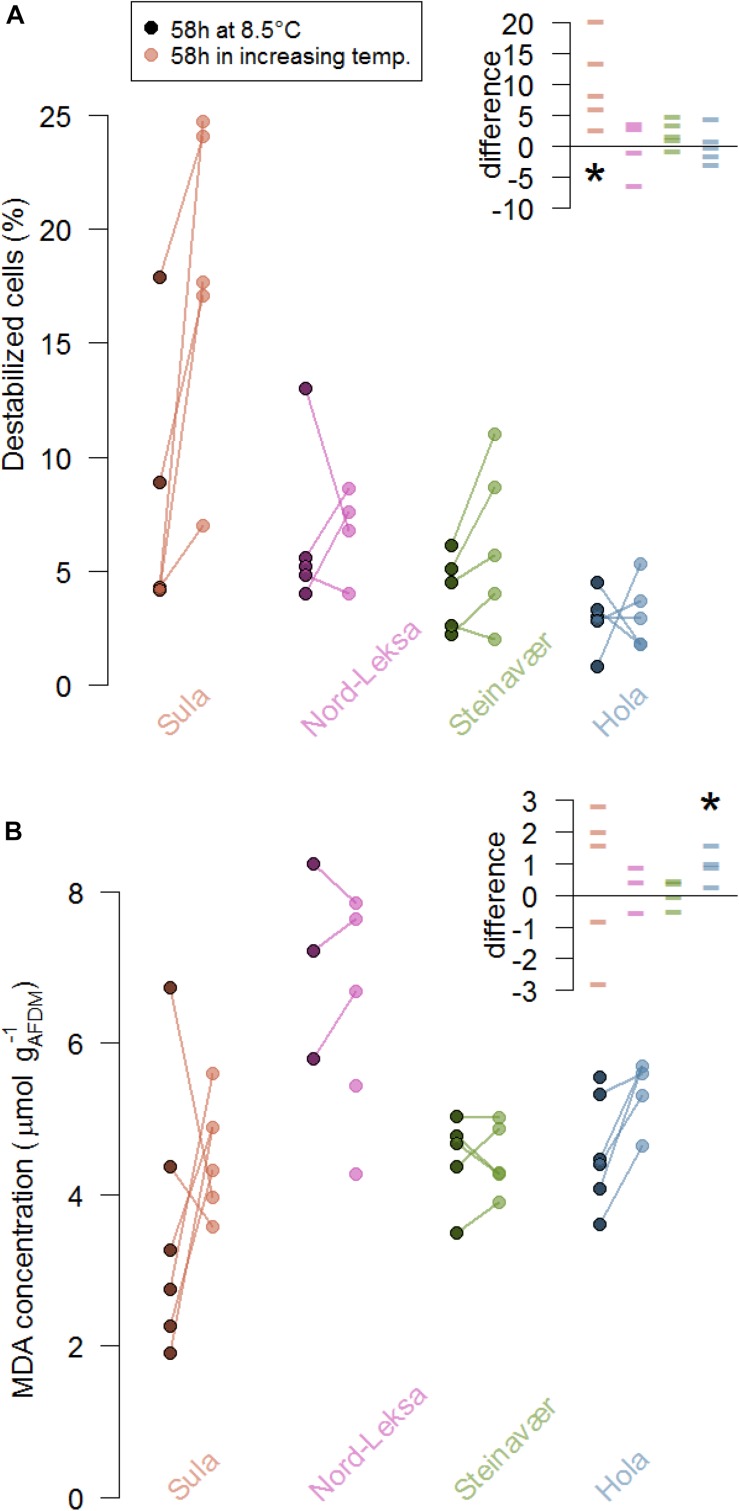
Stress markers of coral fragments from the four reefs (colors) as indicated by (A) lysosome destabilization of the corals’ cells (%) and (B) malondialdehyde concentration (MDA, μmol L−1 gAFDM–1) at the end of the experiment (58 h). At each reef, five colonies were fragmented and five fragments were exposed to increasing temperature (color dots) while five were exposed to ambient temperature (8.5°C, darkened dots). The lines represent the difference between fragments from the same colony. The inserts presents these differences in the coral stress markers (A, % destabilized cells; B, MDA concentration in μmol L−1 gAFDM–1) due to the treatment in each reef (color): Each data point represents the difference between the replicate of one colony exposed to 8.5°C for 58 h and the replicate of the same colony exposed to the temperature increase for 58 h. The stars represent significant differences from zero: (A) the difference in cell destabilization in Sula was significantly different from 0 and (B) the difference in MDA concentration was significantly different from 0 in Hola.